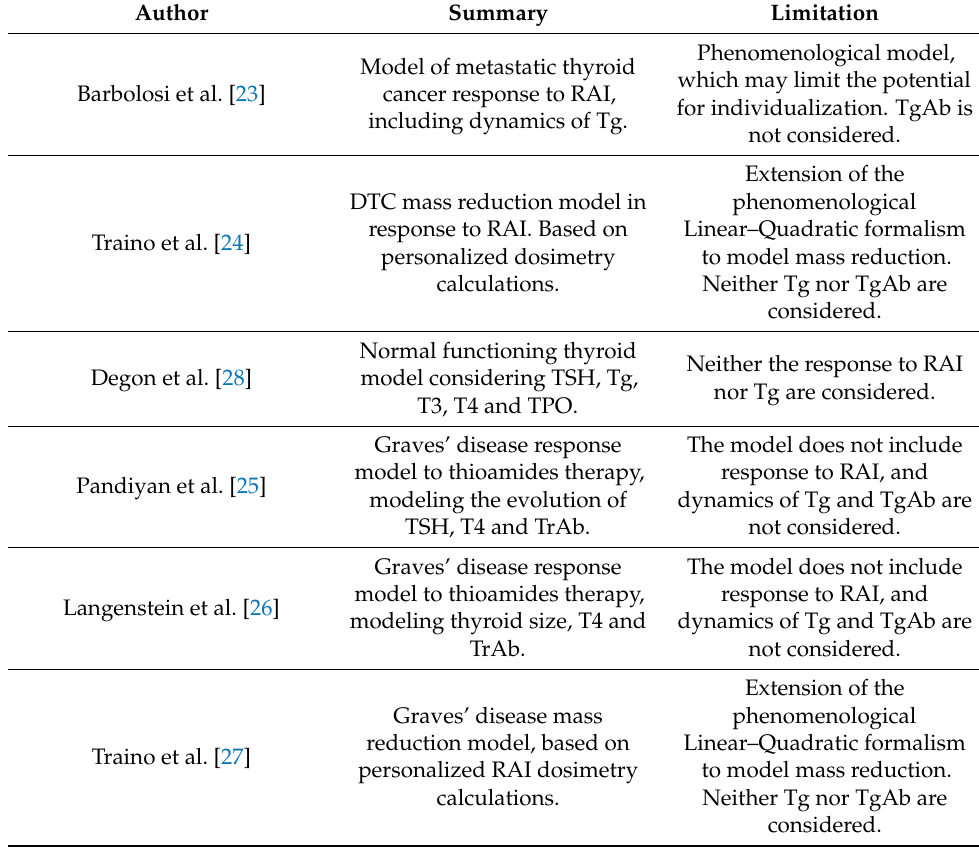
Table 1. List of reviewed mathematical models of thyroid/thyroid cancer